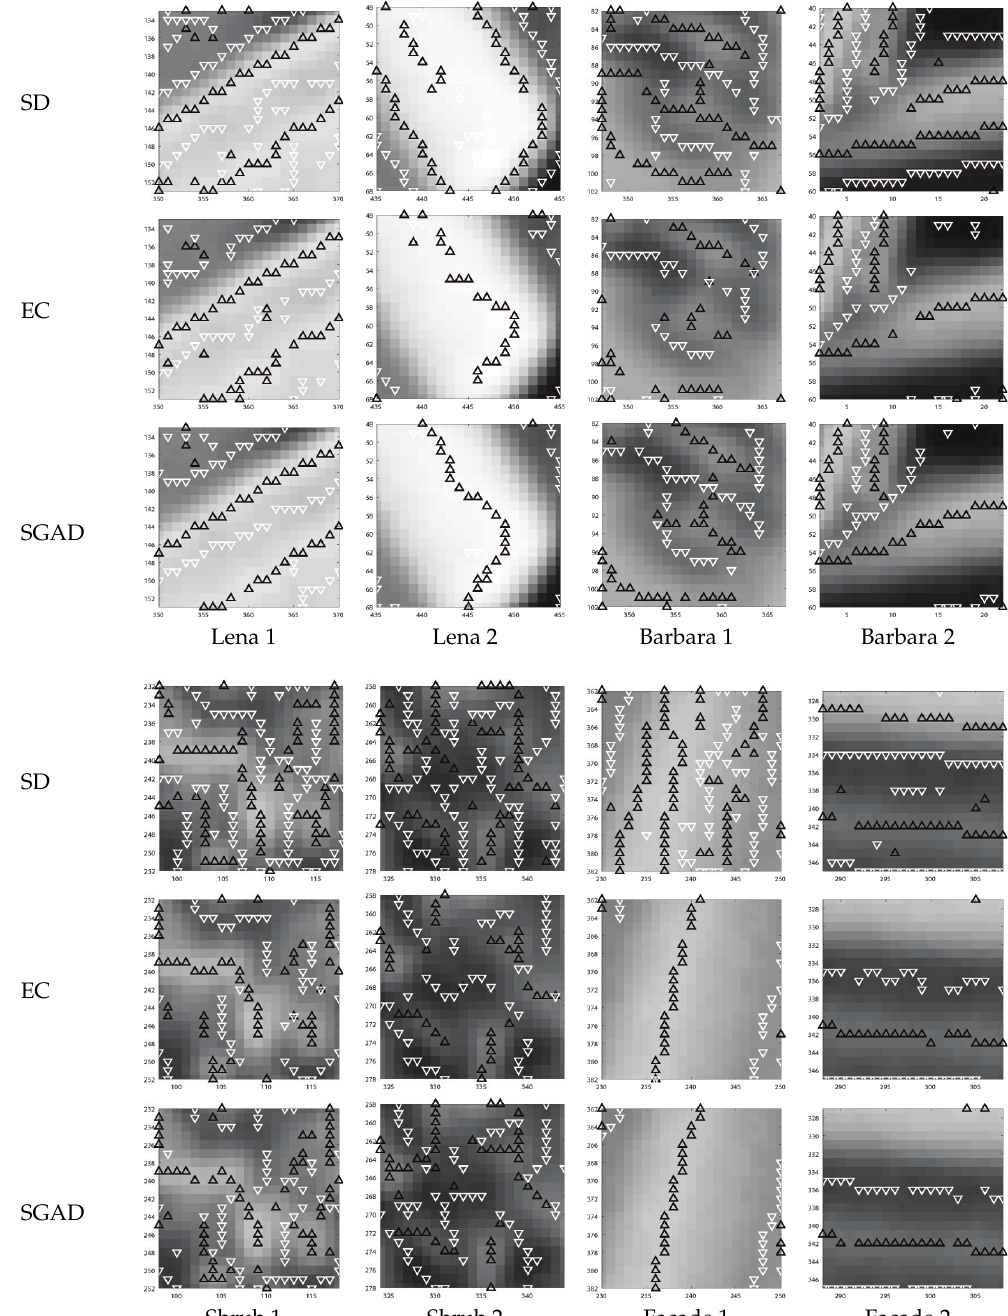
Figure 10. Line-detection results obtained using SD-, EC-, and SGAD-based methods for images contaminated with noise σ n = 5. Ridge and valley pixels are denoted by upward-pointing black and downward-pointing white triangles,